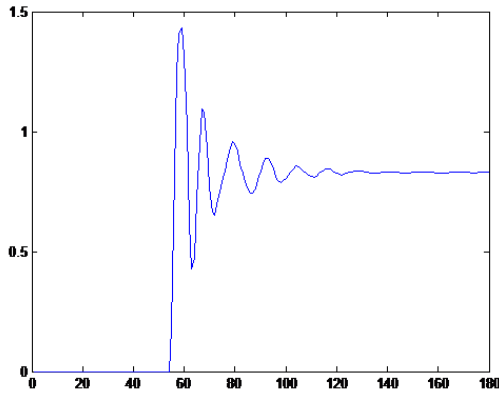
Figure 15. Stepresponse for 80% step input